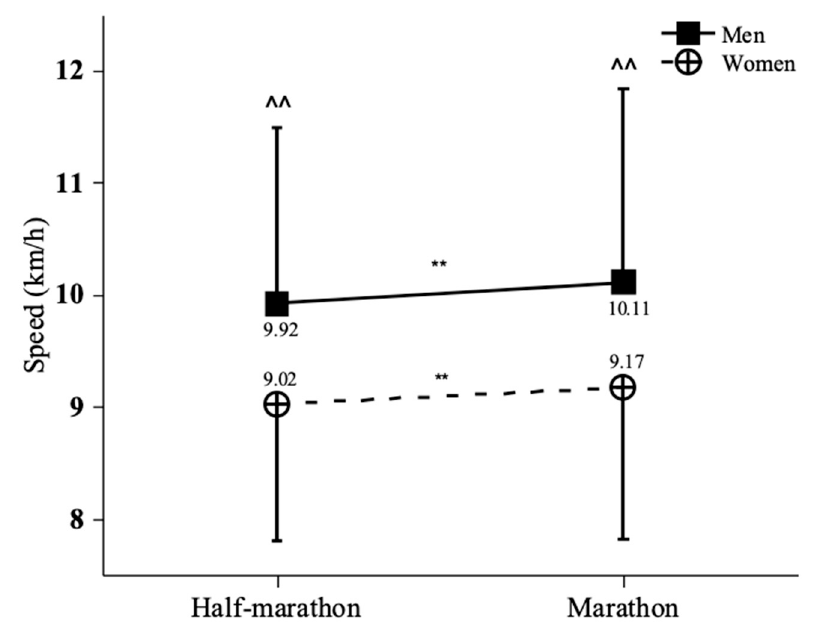
Figure 1. Race speed by race distance and gender. Error bars represent standard deviations. ˆˆ p < 0.001; ** p <